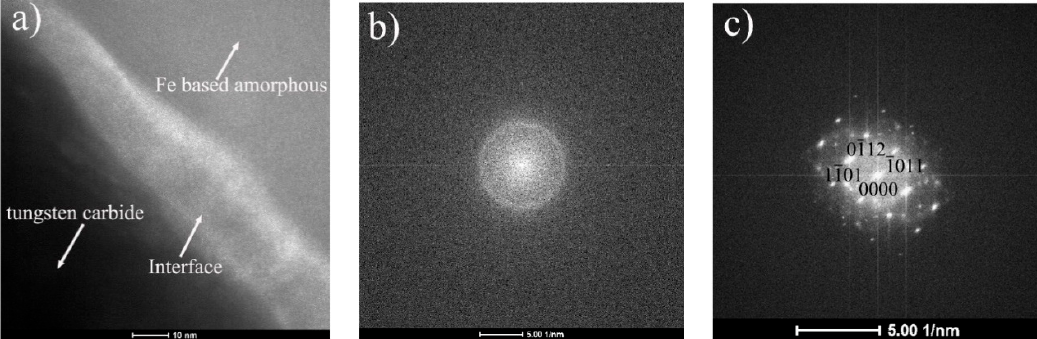
Figure 7. High magnification microstructure of the interface between WC–CoCr cermet and Fe-based amorphous alloy and SAED patterns. ( a ) An enlarged region of tungsten carbide, interface and Fe-based amorphous alloy phase; ( b ) SAED pattern of tungsten carbide phase; ( c ) SEAD pattern of Fe-based amorphous phase.